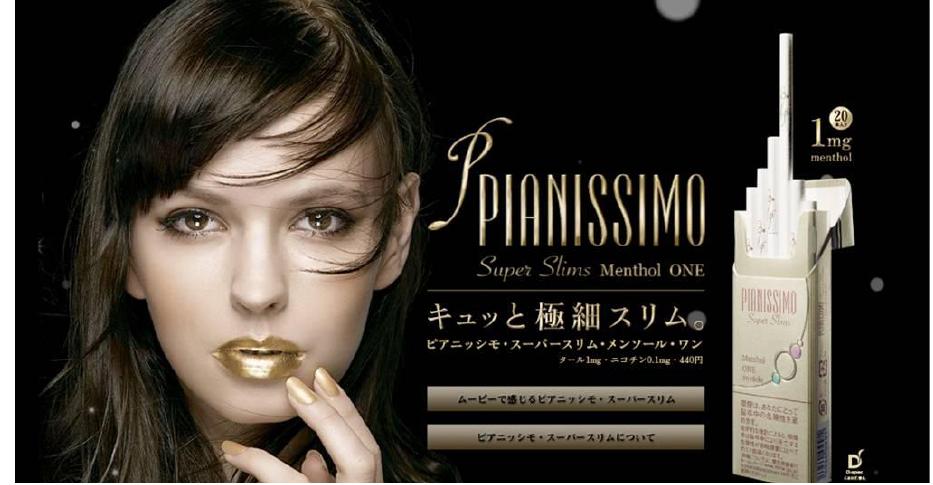
Figure 2. Japanese advertisement for menthol cigarette ‗ Salem Pianissimo Super Slims Menthol One ‘